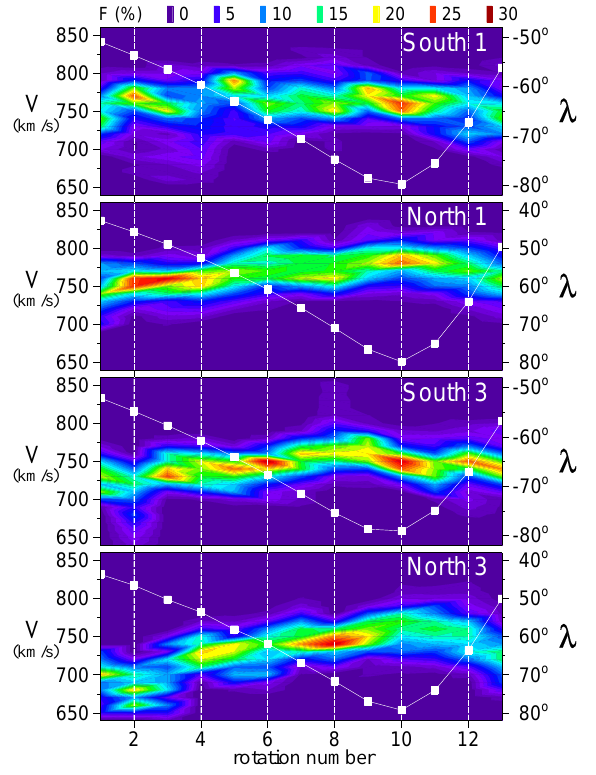
Fig. 2. Two-dimensional plots of V distributions vs. solar rota- tion. Colours give the occurrence frequency (in per cent, see colour scale on top) for each velocity bin (width 10km/s) at each rota- tion. Superposed white squares indicate the rotation average lati- tude λ (right y-axis). From top to bottom: southern and northern phase of the first orbit (South 1 and North 1) and of the third orbit (South 3 and North 3).